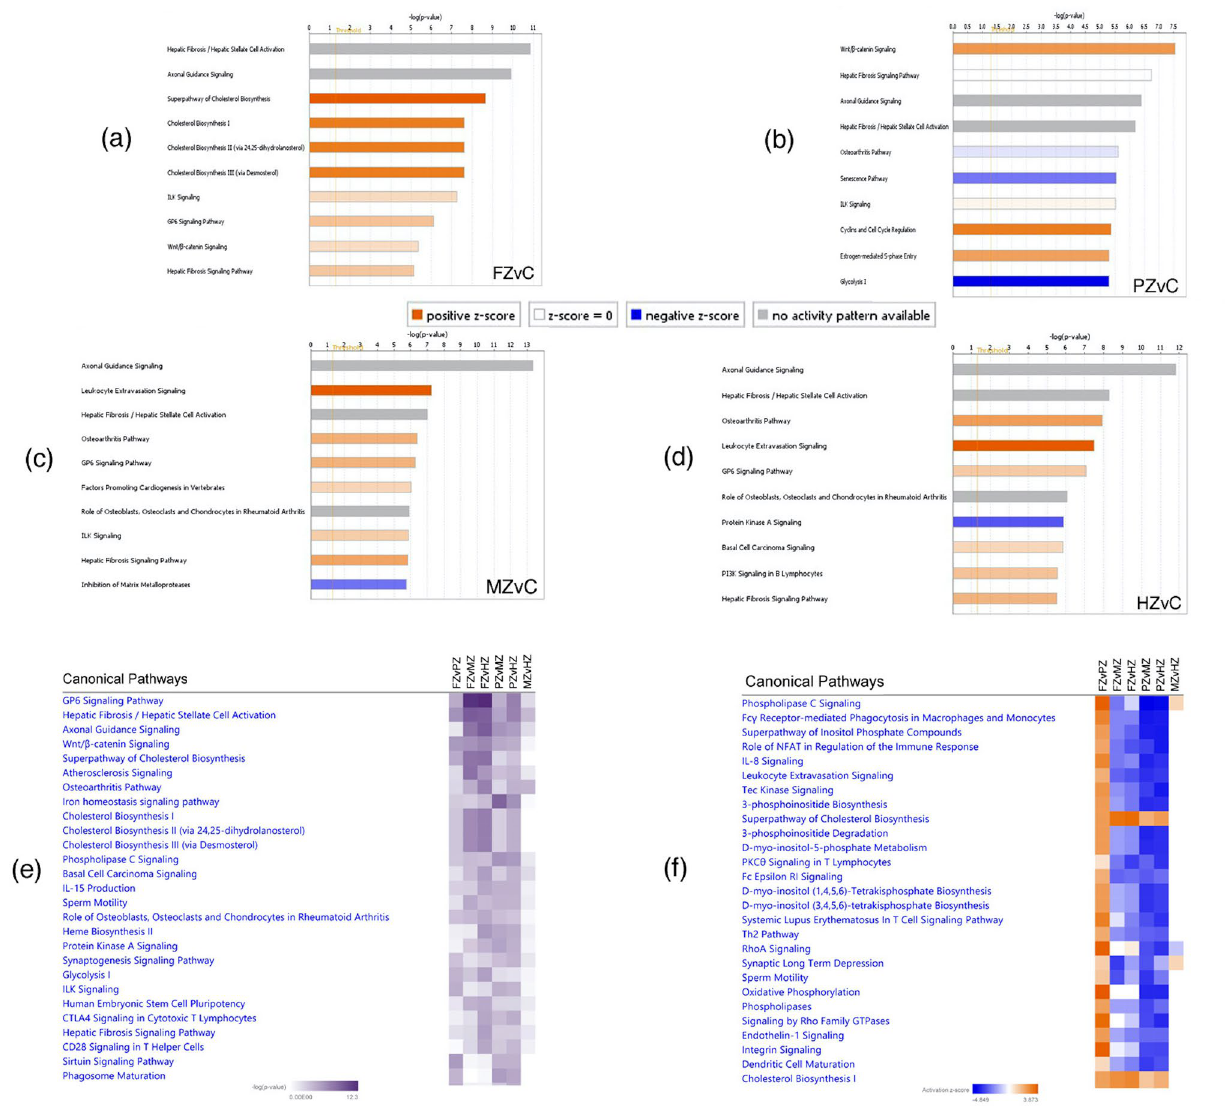
Figure 1. Canonical pathways identified by IPA analysis of the differentially expressed genes. ( a – d ) The top ten significant pathways for four pairwise comparisons; each MCC zone compared with FCC (the control). ( e , f ) Composite summary showing the identified canonical pathways when comparing MCC zones against each other (six comparisons). The pathways are ranked by the negative log of the p-value of the enrichment score and colored according to the z-score. A positive score indicates a significantly increased function (orange), a negative z-score indicates a significantly decreased function (blue), and an undetermined prediction is shown in gray color. Data were analyzed through the use of IPA (QIAGEN Inc., https:// www. qiage nbioi nform atics. com/ produ cts/ ingen uityp athway- analy sis) 29